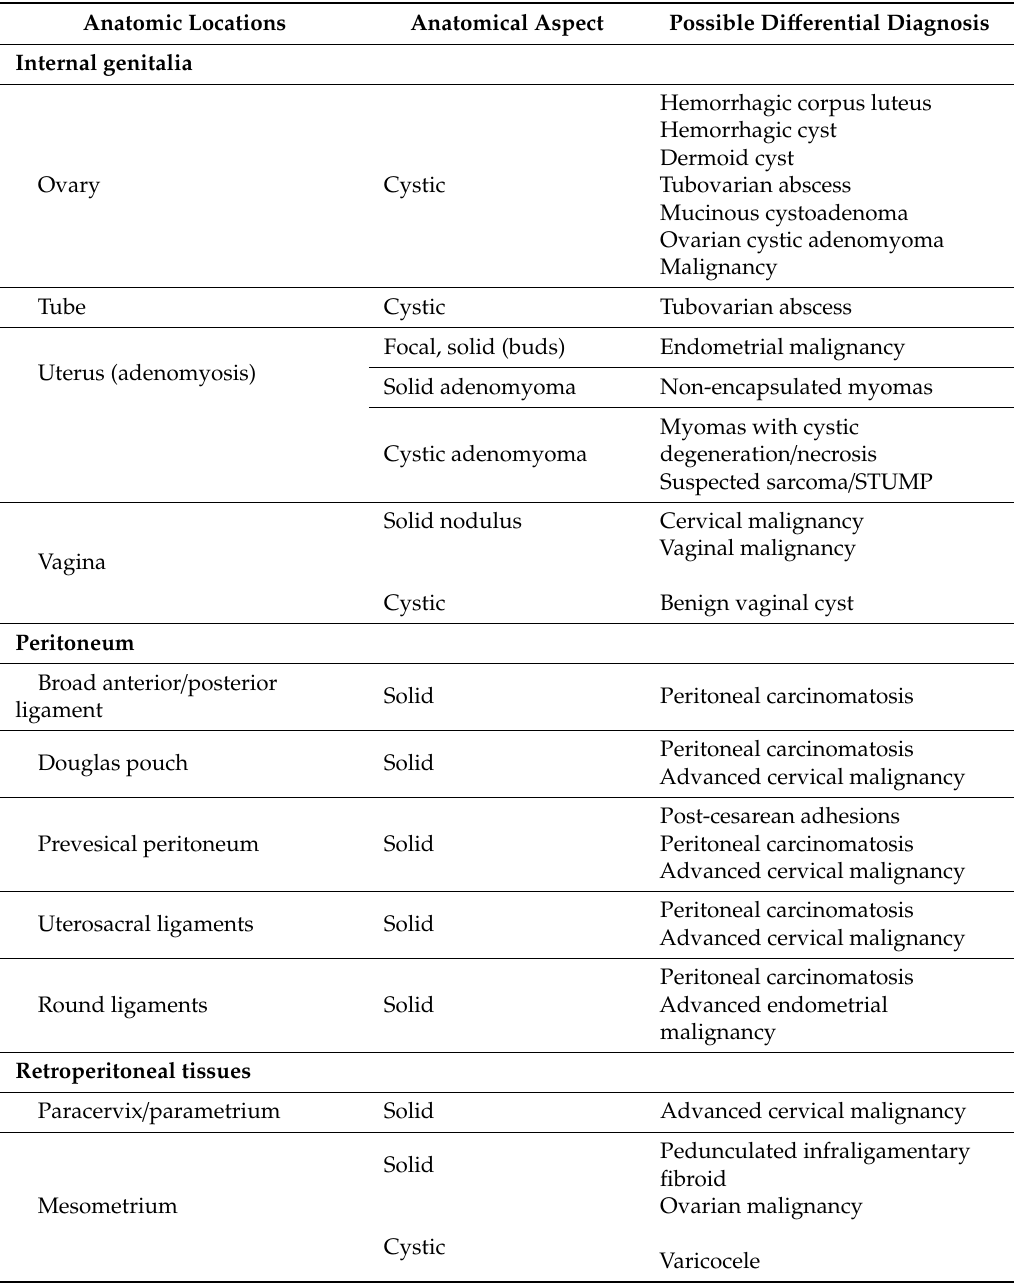
Table 1. Endometriosis possible anatomic locations, anatomical features, and di ff erential